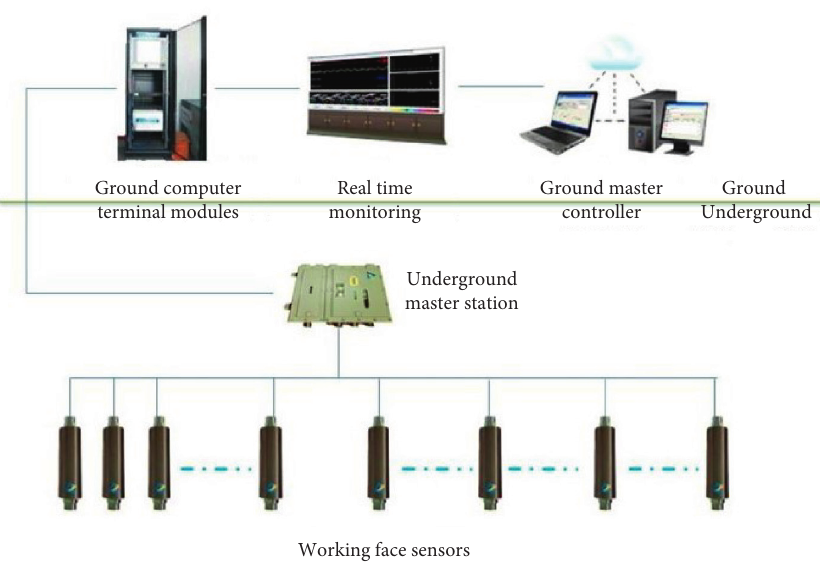
Figure 2: Comparison chart between the 7130 working face and 11071 working face.